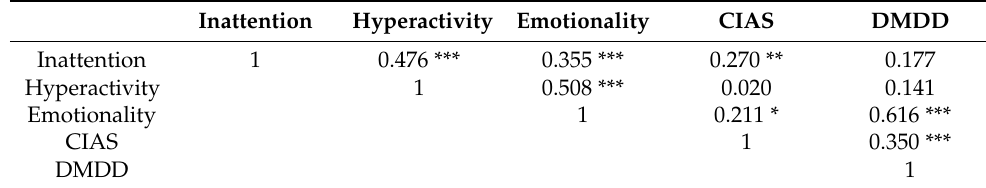
Table 2. Zero-order correlations among study measures.